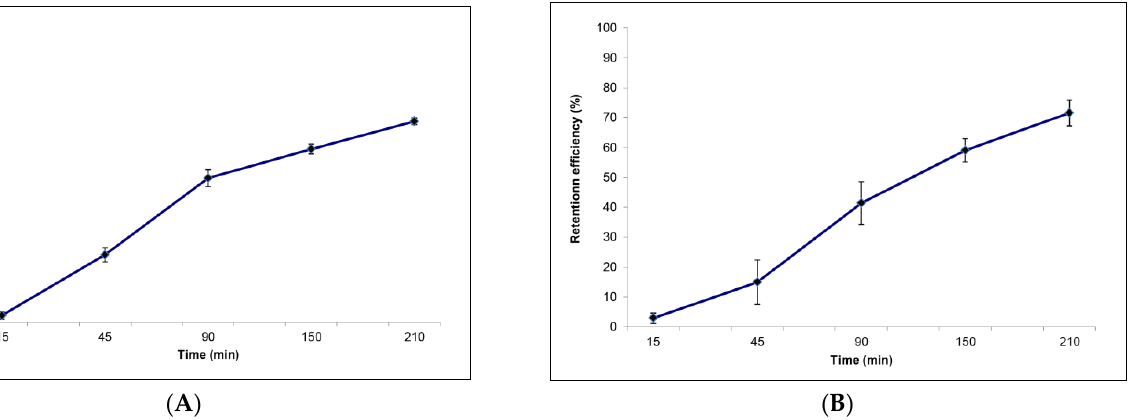
Figure 3. Retention efficiency calculated within each sampling time for ( A ) Sabella spallanzanii and ( B ) Branchiomma luctuosum .